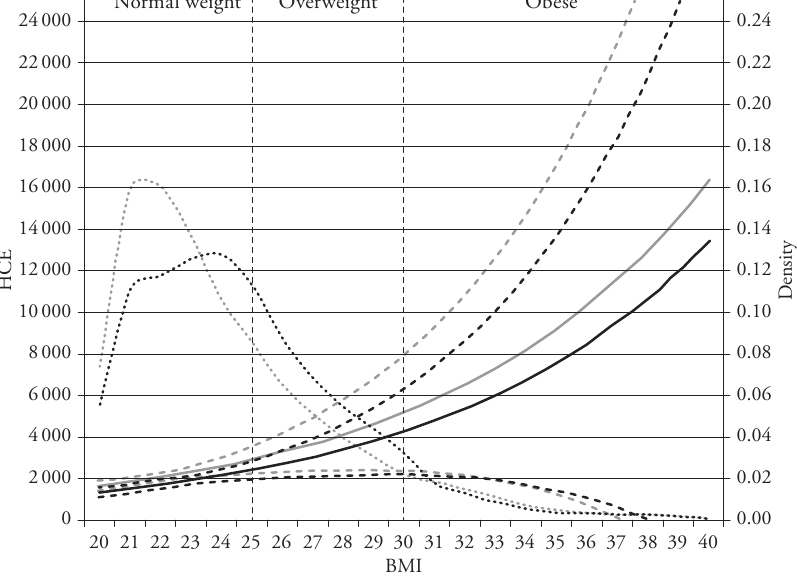
Figure 1: Predicted Relationship between BMI and HCE for Men and Women Normal weight Overweight